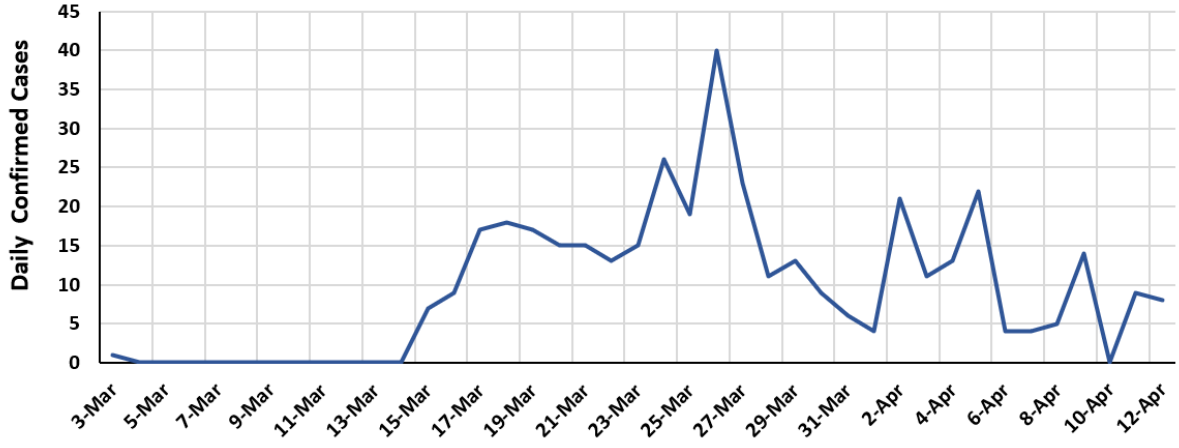
Figure 1. The number of daily confirmed coronavirus disease cases as of April 12,